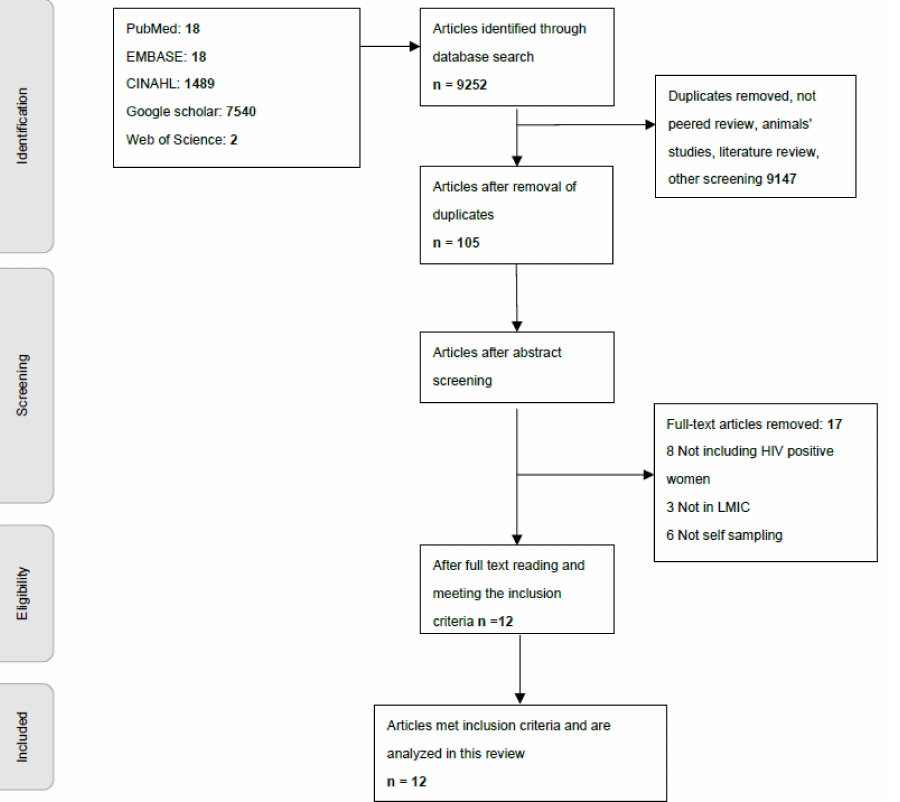
Figure 1. PRISMA flow chart of the search